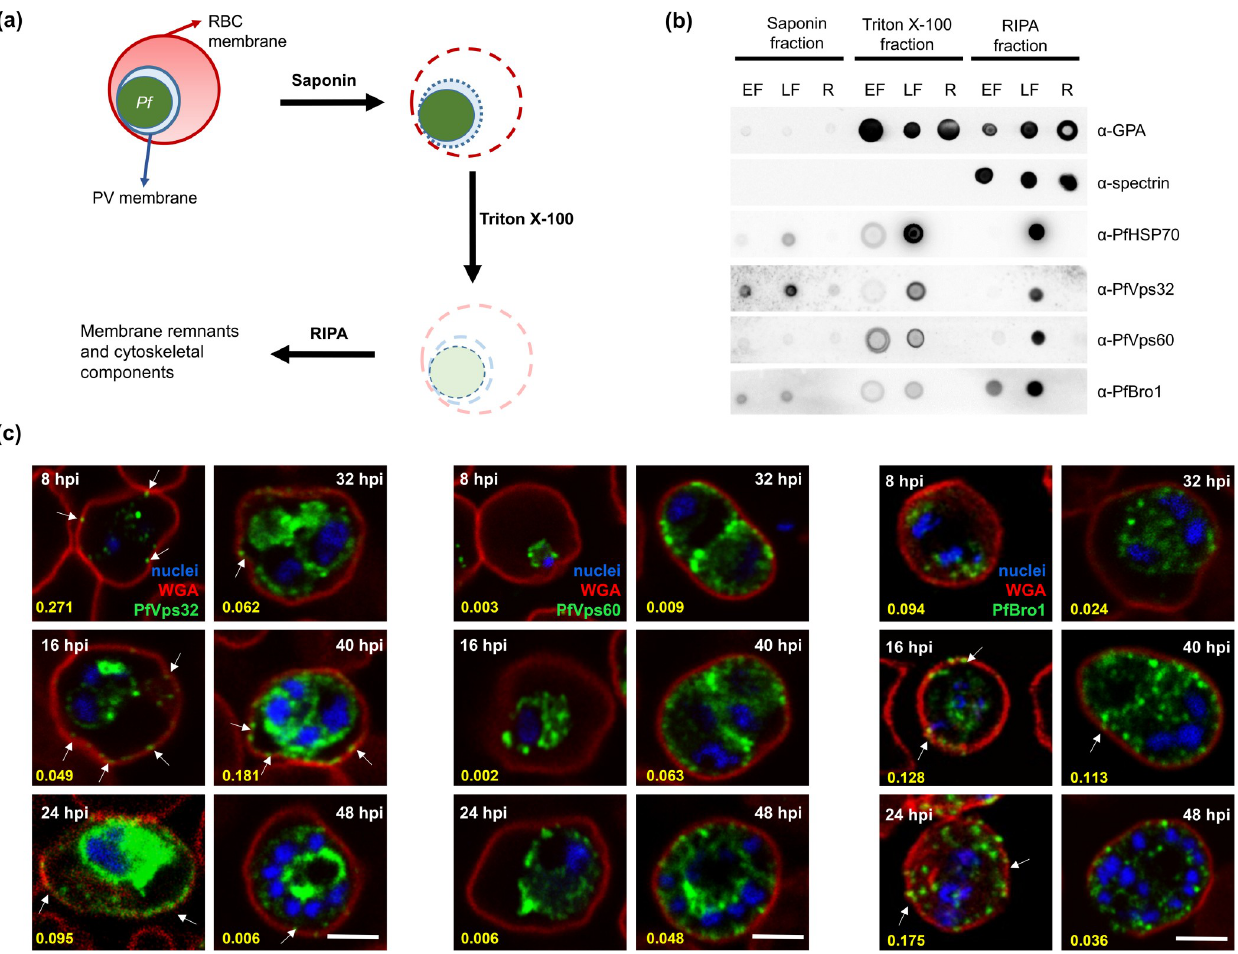
Fig 1. Expression and localization of PfVps32, PfVps60 and PfBro1 during the P . falciparum intraerythrocytic cycle. (a) Diagram illustrating the approach for the differential detergent fractionation protocol used for obtaining saponin, Triton X-100 and RIPA fractions. (b) Dot-blot assays performed with the different pRBCs extracts at early (8 hpi, EF) and late forms (40 hpi, LF) after RBC invasion using the different antibodies as indicated. As control, extracts obtained from non-infected RBCs (R) were also included. (c) Human erythrocytes were infected with P . falciparum and fixed at different hpi. PfVps32, PfVps60 or PfBro1 (green) were detected by indirect confocal immunofluorescence microscopy and WGA (red) was used to label the RBC plasma membrane. Cell nuclei were visualized with Hoechst 33342 (blue). Arrows show protein-labeled puncta adjacent to the membrane of the pRBCs. Numbers in yellow indicate Manders’ overlap coefficients used to evaluate co-localization between WGA and each protein tested. Scale bar: 5 μ m.